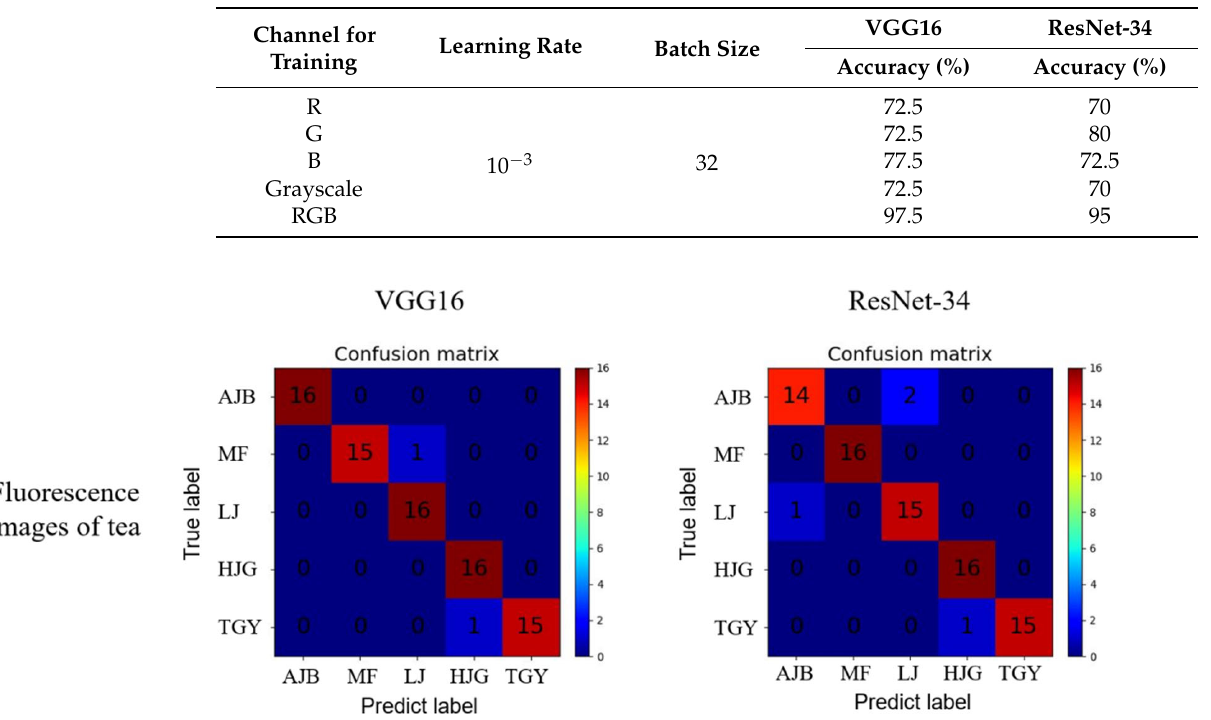
Table 1. The classification accuracy of fluorescence images.